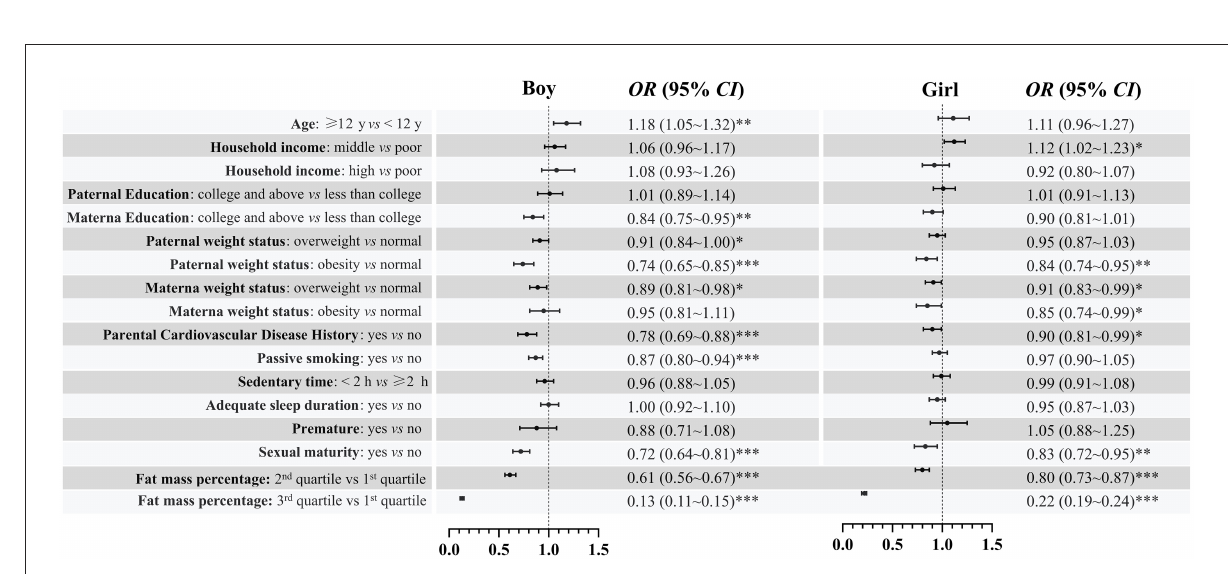
FIGURE5 Association [OR (95%CI)] between demographic factors and ideal cardiovascular health among children and adolescents in Beijing by sex. *0.01 ≤ P < 0.05; **0.001 ≤ P < 0.01; *** P <